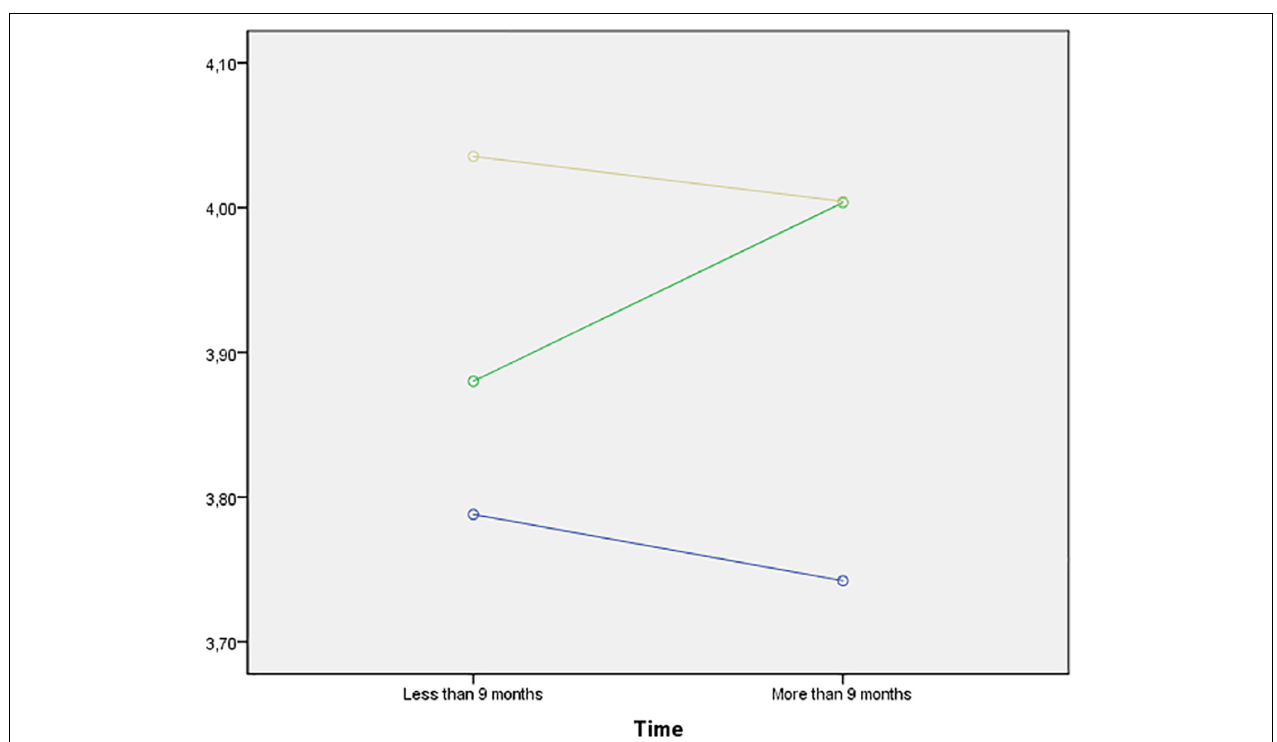
FIGURE 1 | Mean values of confidence (factor 1) by educational level and time of residence. Note: Blue (Primary Education; Green (Secondary Education); Yellow (Baccalaureate—Vocational Training).